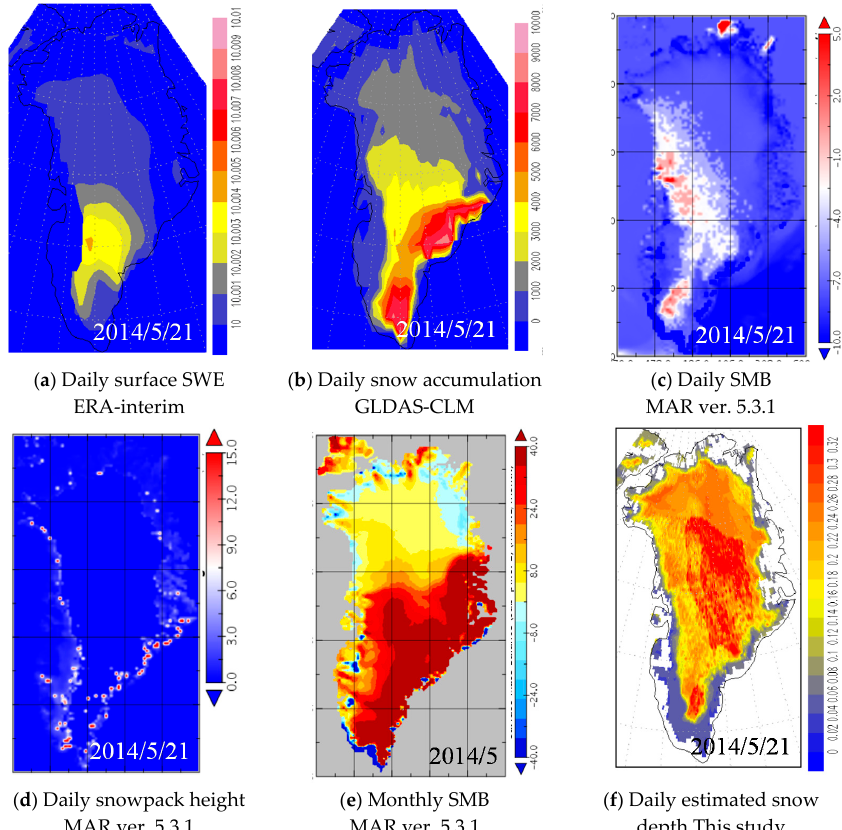
Figure 12. Daily spatial resolution on 21 May 2014 for ( a ) the daily surface snow water equivalent (SWE; m) from ERA-interim, with 0.75° spatial resolution; ( b ) the daily surface accumulation of snow (kg/m 2 ) from GLDAS-CLM, with 1° spatial resolution; ( c ) the daily surface mass balance (SMB; mm WE/day; WE = water equivalent) from MAR ver. 5.3.1 based on NCEPv1; ( d ) daily snowpack height above ice (m) from MAR ver. 5.3.1 based on NCEPv1, with 0.2° spatial resolution; ( e ) the monthly surface mass balance (SMB; mm WE/month) from MAR ver. 5.3.1, as a reference; and ( f ) daily estimated snow depth (cm) from this study, with 0.25° spatial resolution.